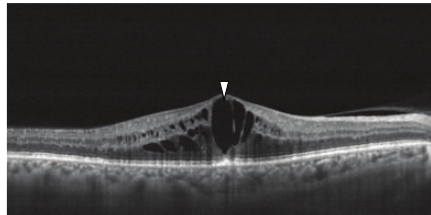
Figure 2: Cystoid macular edema can be seen clearly on OCT scans as multiple circular cystic spaces in the retina, indicating intraretinal edema (white arrowhead). The cystic spaces are round and originate around the outer plexiform layer.